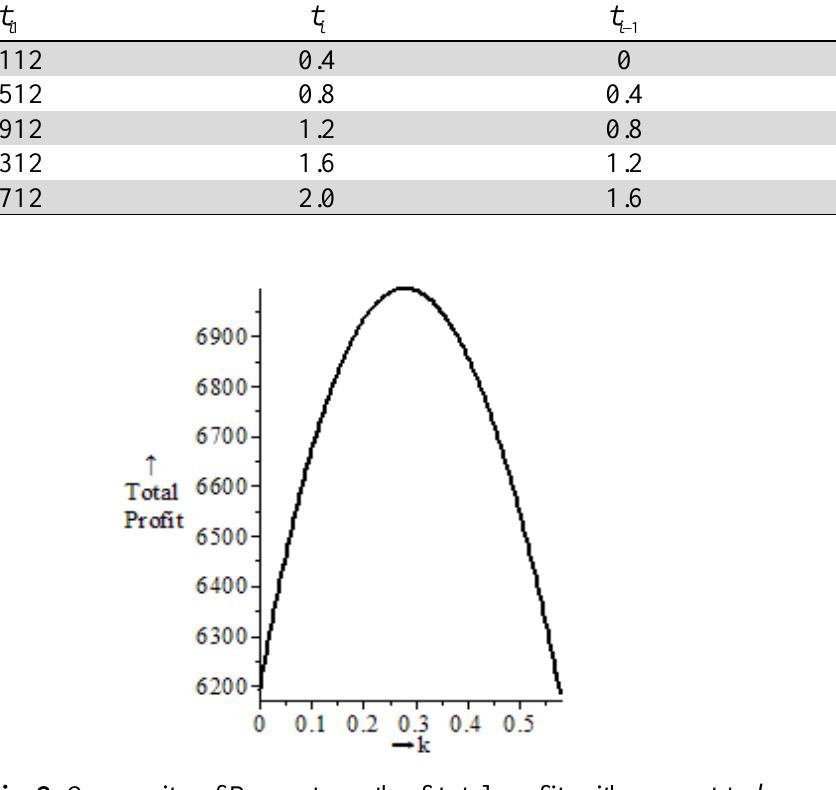
Fig. 2. Concavity of Present worth of total profit with respect to